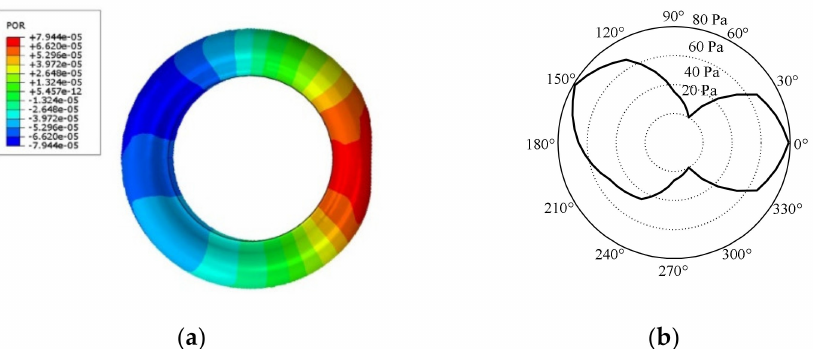
Figure 13. The acoustic pressure distribution for the inflation pressure of 2.5 bar: ( a ) Distributions contour of the acoustic pressure amplitude; ( b ) Distributions of the acoustic pressure amplitude in the polar